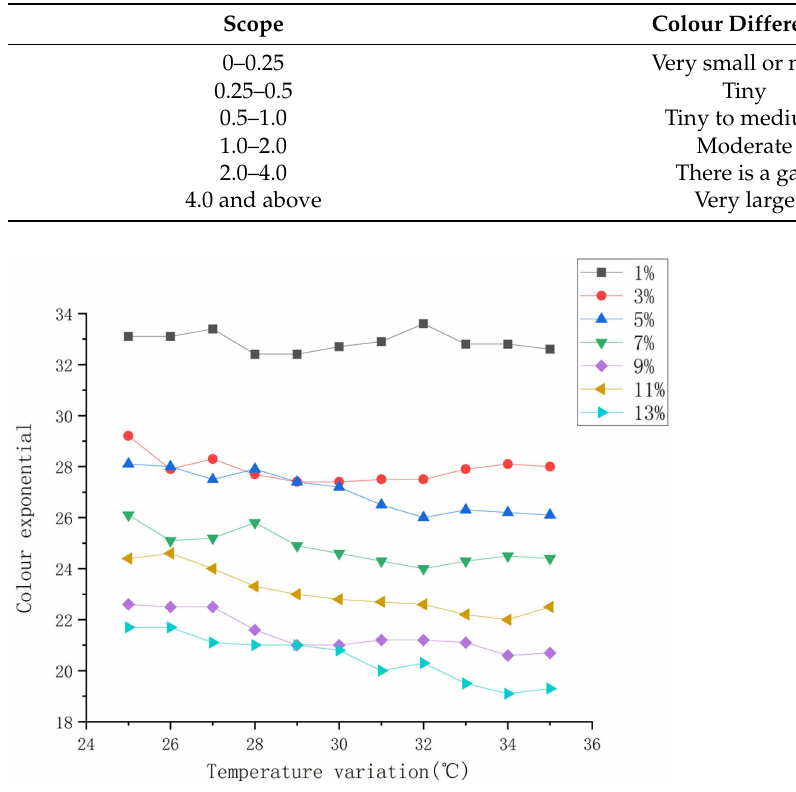
Figure 5. Colour–change diagram of water–based coating microcapsule with core wall ratio of 0.033 colour–changing powder b–value when heating